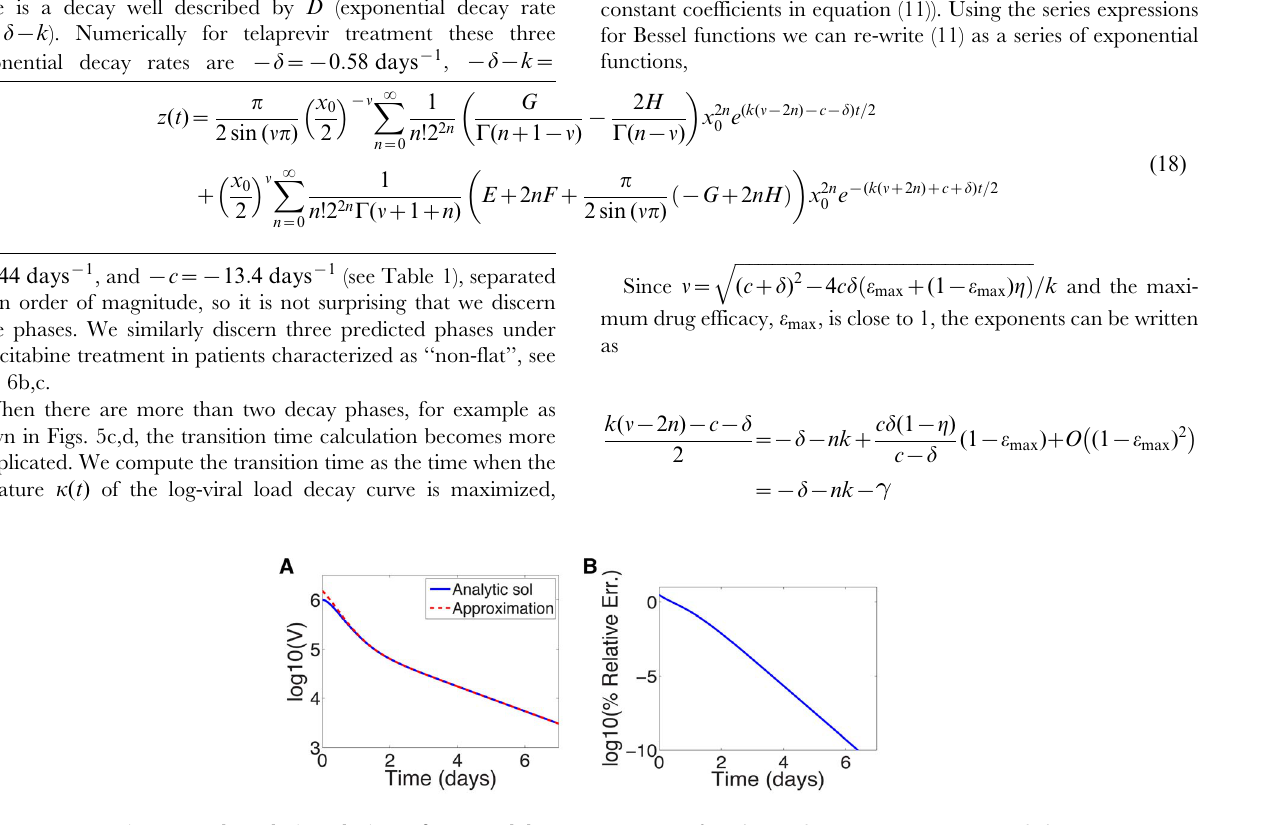
Figure 3. Approximate and analytic solution of VE model. (a) Comparison of analytic solution (equation (11)) and the approximation (equation (16)) assuming sibilinin treatment (see Table 1 for parameters) and initial viral load of 10 6 IU = mL . (b) Relative error in log 10 of approximation.